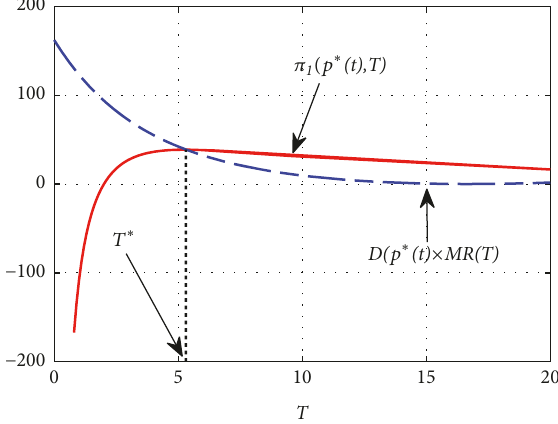
Figure 5: The optimal replenishment period.